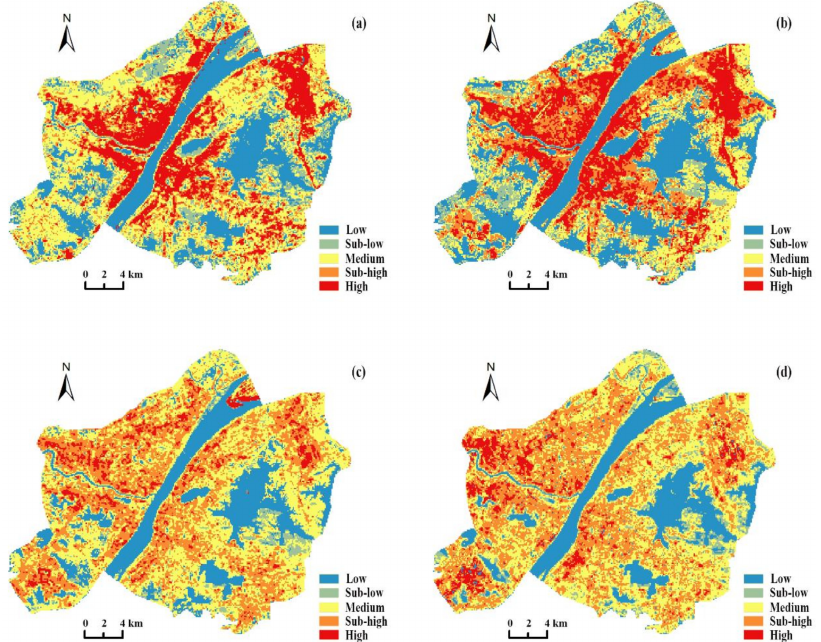
Figure 2. Spatial distribution maps of normalized land surface temperature (NLST) levels in 1987 ( a ), 1996 ( b ), 2007 ( c ) and 2016 ( d